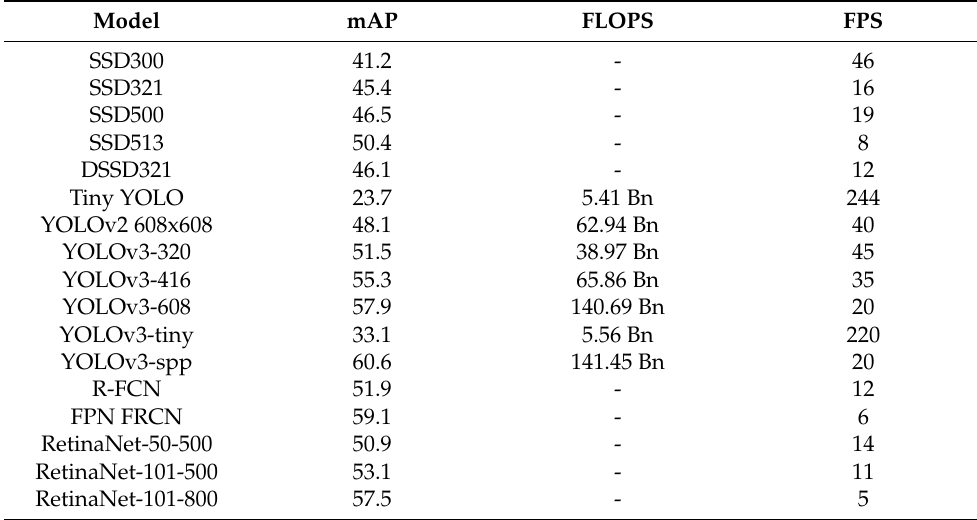
Table 2. Frame speed comparison of the deep learning models.